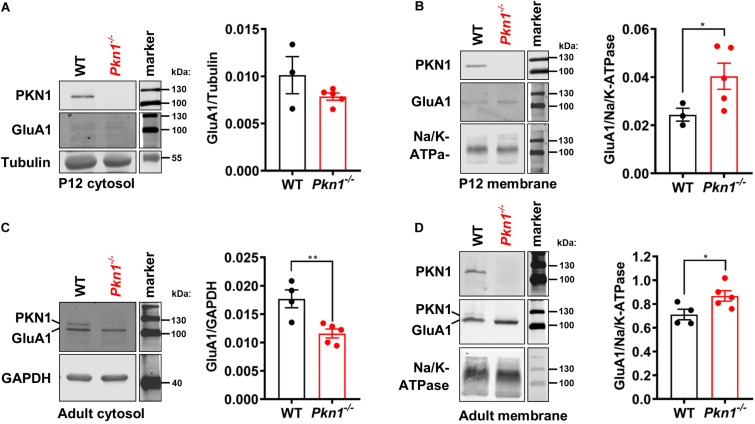
Postnatal and adult Pkn1–/– animals show enhanced membrane-association of GluA1. (A) The detergent-soluble cytosolic fraction of extracts prepared from P12 old WT and Pkn1–/– hippocampi was probed for the loading control Tubulin and GluA1 (P = 0.393, unpaired t-test). (B) The detergent-insoluble membrane fraction of extracts prepared from P12 old WT and Pkn1–/– hippocampi was probed for the loading control Na+/K+-ATPase and GluA1 (*P = 0.0416, unpaired t-test). (C) The detergent-soluble cytosolic fraction of extracts prepared from adult WT and Pkn1–/– hippocampi was probed for the loading control GAPDH and GluA1 (**P = 0.0075, unpaired t-test). (D) The detergent-insoluble membrane fraction of extracts prepared from adult WT and Pkn1–/– hippocampi was probed for the loading control Na+/K+-ATPase and GluA1 (*P = 0.0430, unpaired t-test). All data is presented as individual n-values with mean ± S.E.M. Images of PKN1 in (A,B) were derived from a second blot, loaded in the same order. All markers in the representative blots are shown in separate lanes as samples were not next to the markers in the blots.